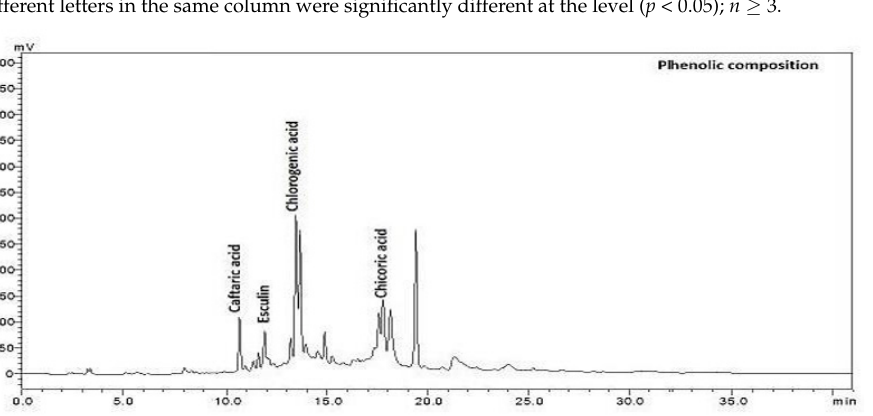
Table 3. Concentration of inulin of Cichorium intybus L. using a spectrophotometer ([4]). Sample